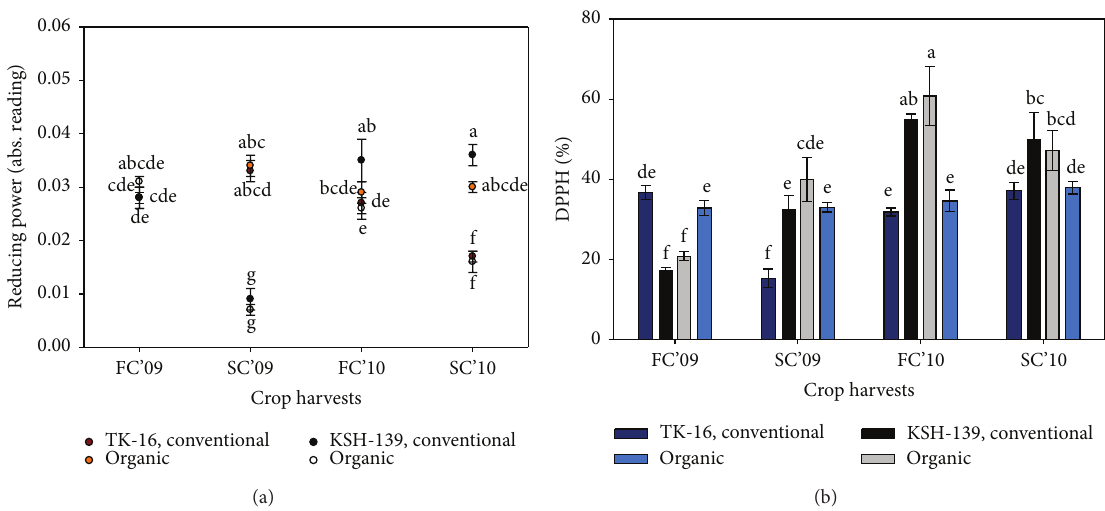
Figure 2: Influence of farming practices on (a) reducing power; and (b) DPPH% of two rice cultivars under different seasons. FC’09 = first crop (February–June) of 2009; SC’09 = second crop (August–November) of 2009; FC’10 = first crop (February–June) of 2010; SC’10 = second crop (August–November) of 2010. Values with different letters are significantly different ( ± S.E.) 𝑃 ≤ 0.05 (DMRT).